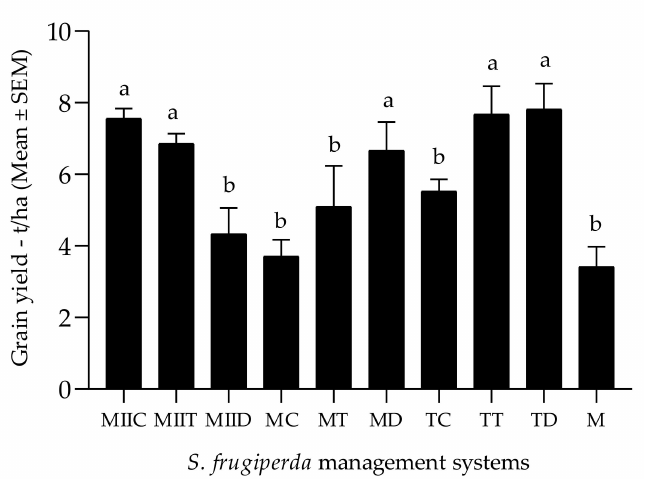
Figure 8. Maize grain yields (Mean ± SEM) in the evaluated management systems. Different letters indicate significant difference ( p < 0.05) by the Scott–Knott test ( α = 0.05). For abbreviations, see